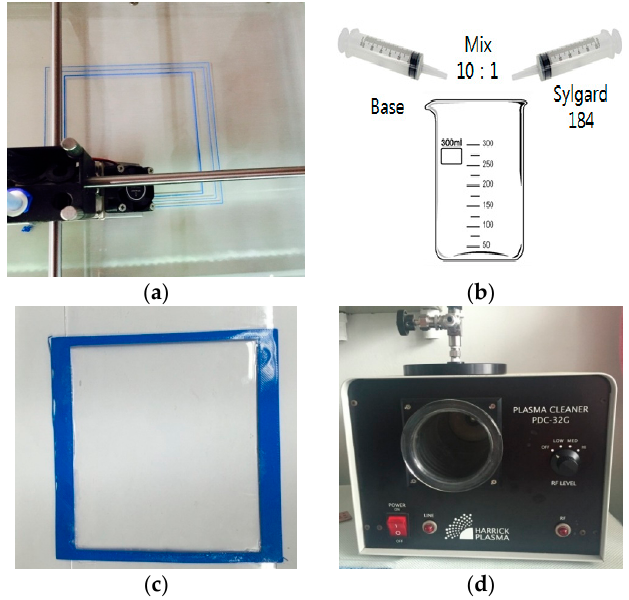
Figure 4. Polydimethylsiloxane (PDMS) fabrication process. ( a ) 3D printed molding of the PDMS substrate; ( b ) Mixing the base and curing agent; ( c ) Pouring liquid PDMS into the fabricated outline; ( d ) Plasma treatment processing.